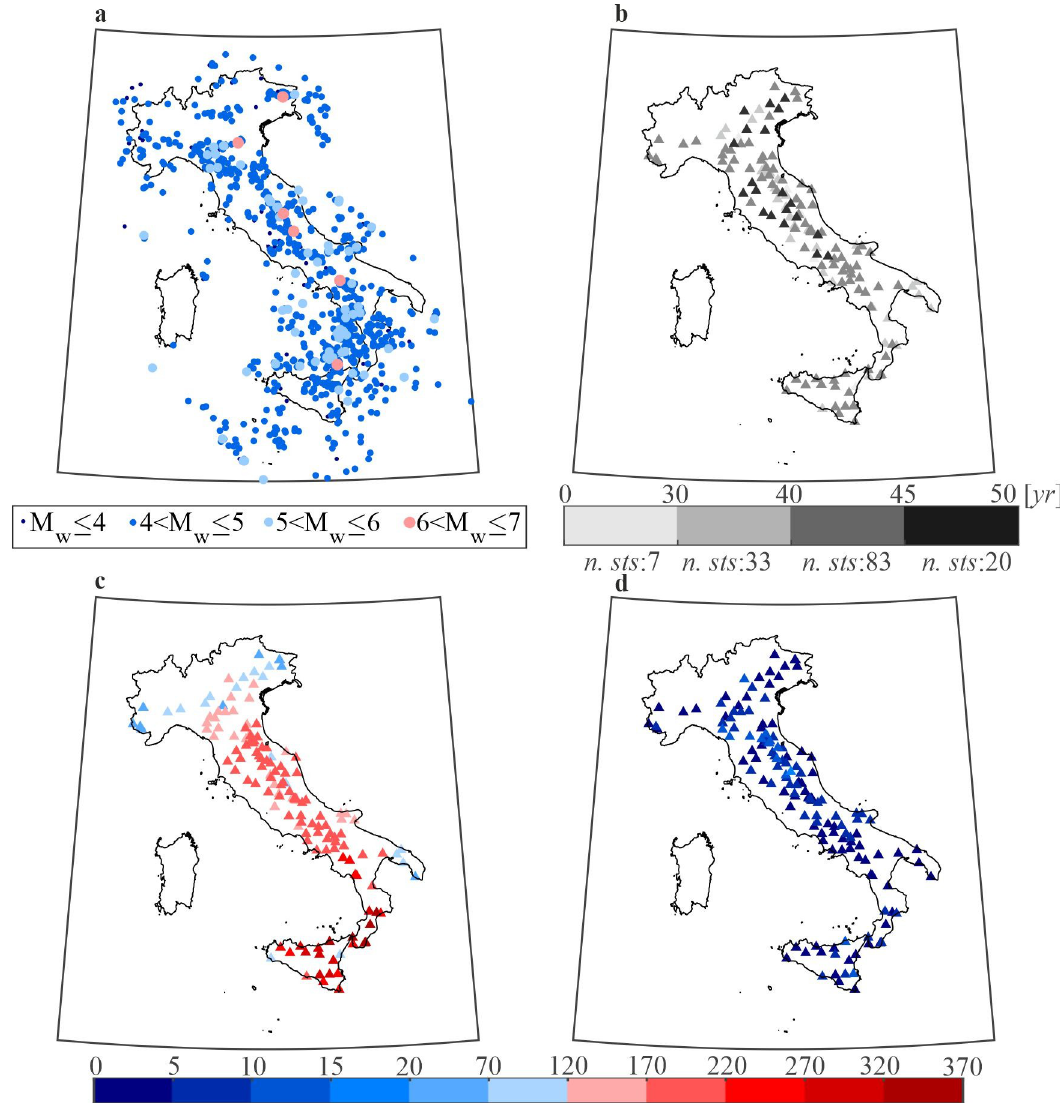
Fig 2. Earthquakes and stations considered in the study. (a) M3.7+ mainshocks from 1973 to 2019 according to CPTI15. (b) Considered stations and their operating time (in terms of number of years). (c) Number of mainshocks within 200 km per station during operating time according to CPTI15. (d) number of recorded mainshocks for each station. The maps were generated using the Matlab mapping toolbox version 4.10